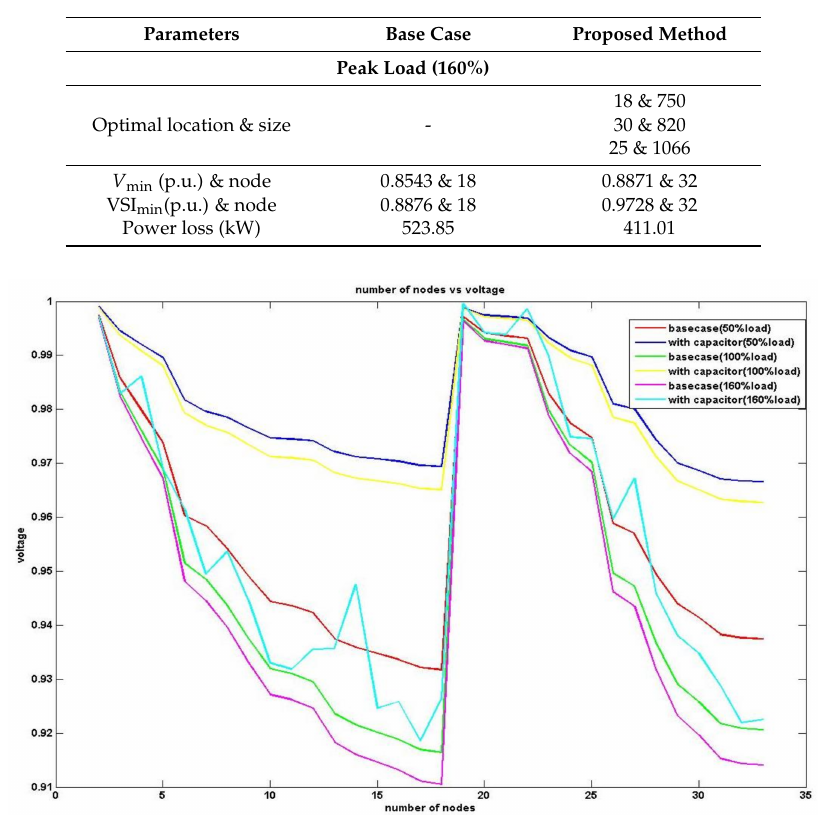
Figure 3. Voltage magnitude vs. the number of nodes with and without the capacitor.